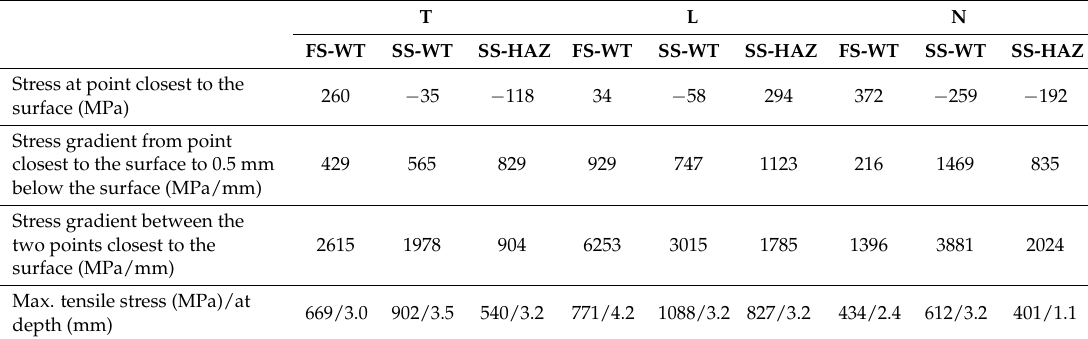
Table 7. A summary of the stress at the point closest to the surface, near surface residual stress gradient and maximum tensile stress for the three positions in the transverse (T), longitudinal (L) and normal (N) directions. T L N FS-WT SS-WT SS-HAZ FS-WT SS-WT SS-HAZ